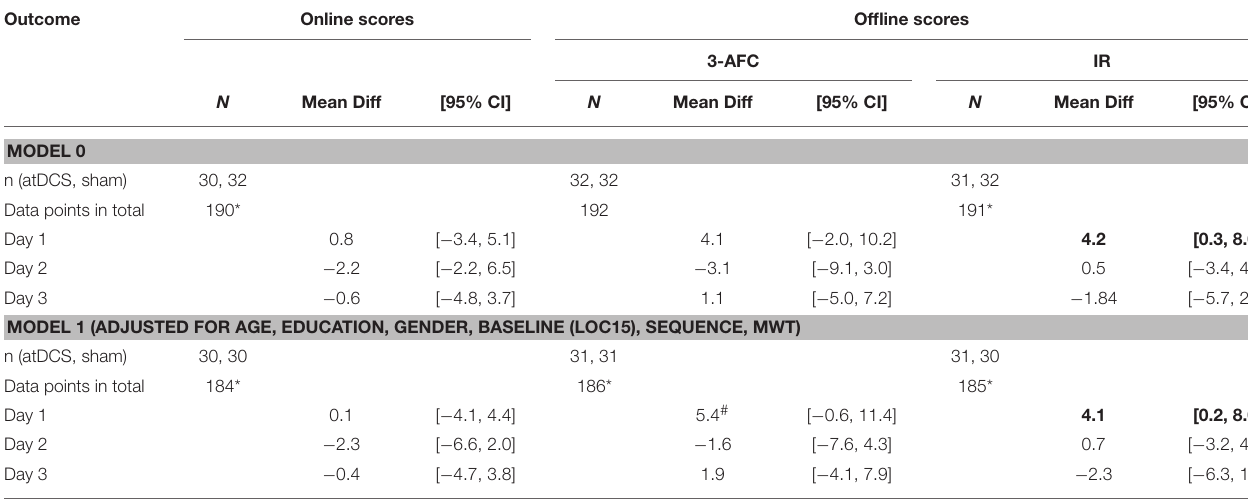
TABLE 3 | Mean Difference (Mean Diff) atDCS-sham and 95% CI of model based post-hoc comparisons between atDCS and sham for online (assessed as within-session difference performance score on each training day) and offline scores (assessed as overnight difference performance score between training sessions for 3-AFC and IR-scores) without (MODEL 0) and with adjustment (MODEL 1).